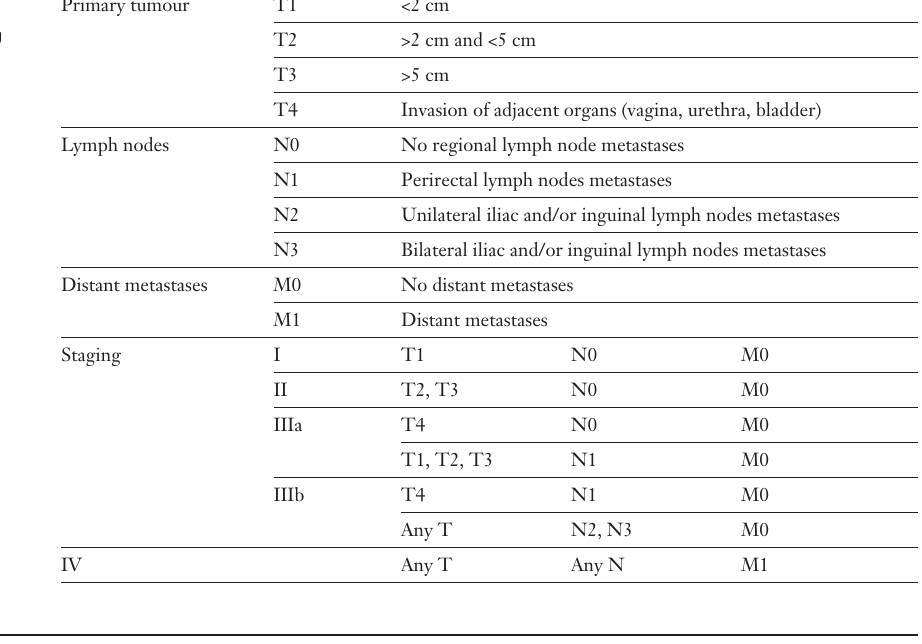
AJCC/UICC staging of anal cancer.